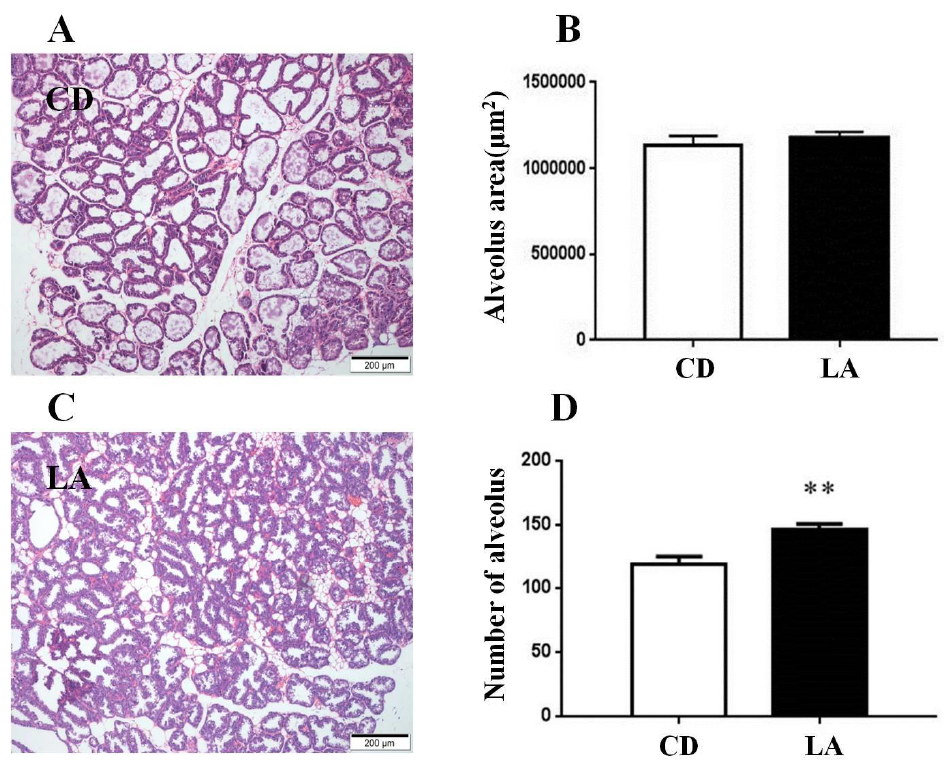
Figure 2. The results of H&E staining. ( A, C ) The fourth pair of mammary glands with control and 1% LA treated lactating mice, the scale bars are shown in the images. ( B ) The effect of dietary 1%